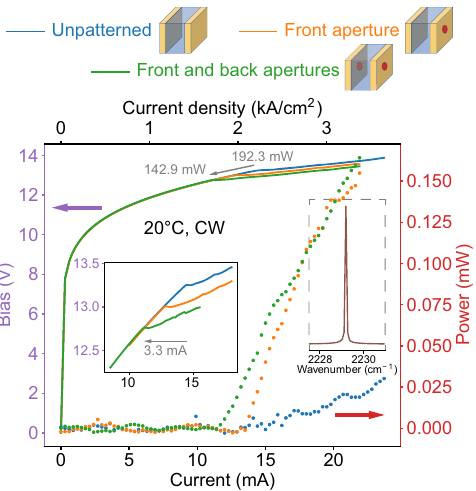
Fig. 2 Lasing threshold reduction. Continuous-wave (CW) current- voltage-power characteristics measured at room temperature with a short- cavity QCL where highly re fl ective metallic coatings are applied on both laser facets. The blue line and dots show the results where no apertures are patterned on the coatings. The orange line and dots show the results measured when a 950-nm-diameter circular hole is created in the metal layer of the coating on the front side. The green line and dots display the measured results when an additional 950-nm-diameter circular hole is milled in the Au fi lm of the back-facet high-re fl ectivity coating. In these characterizations, the measuring step is 0.3 mA. A reduction of the threshold current is shown by the movement of the current-voltage kinks toward the left, and are more clearly displayed in the left inset, where the measurements are conducted using a fi ner current step of 0.1 mA. In total, the threshold dissipation power is reduced by over 25%. The laser is single- mode at the threshold, as shown in the right inset, where the spectral resolution of the measurement is 0.075cm − 1 . ⓒ 2021 IEEE. Figure 2 is reprinted, with permission, from ref. 20